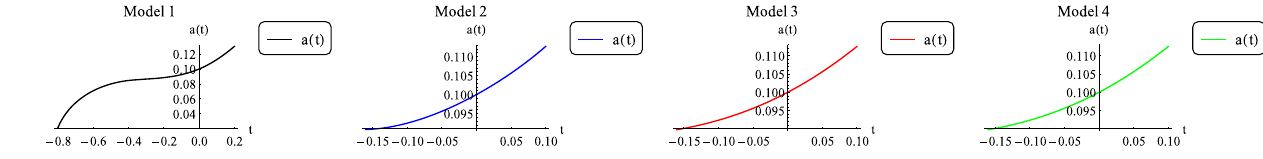
Fig. 2 The scale-factor, a ( t ) , in terms of cosmic-time under different viable models